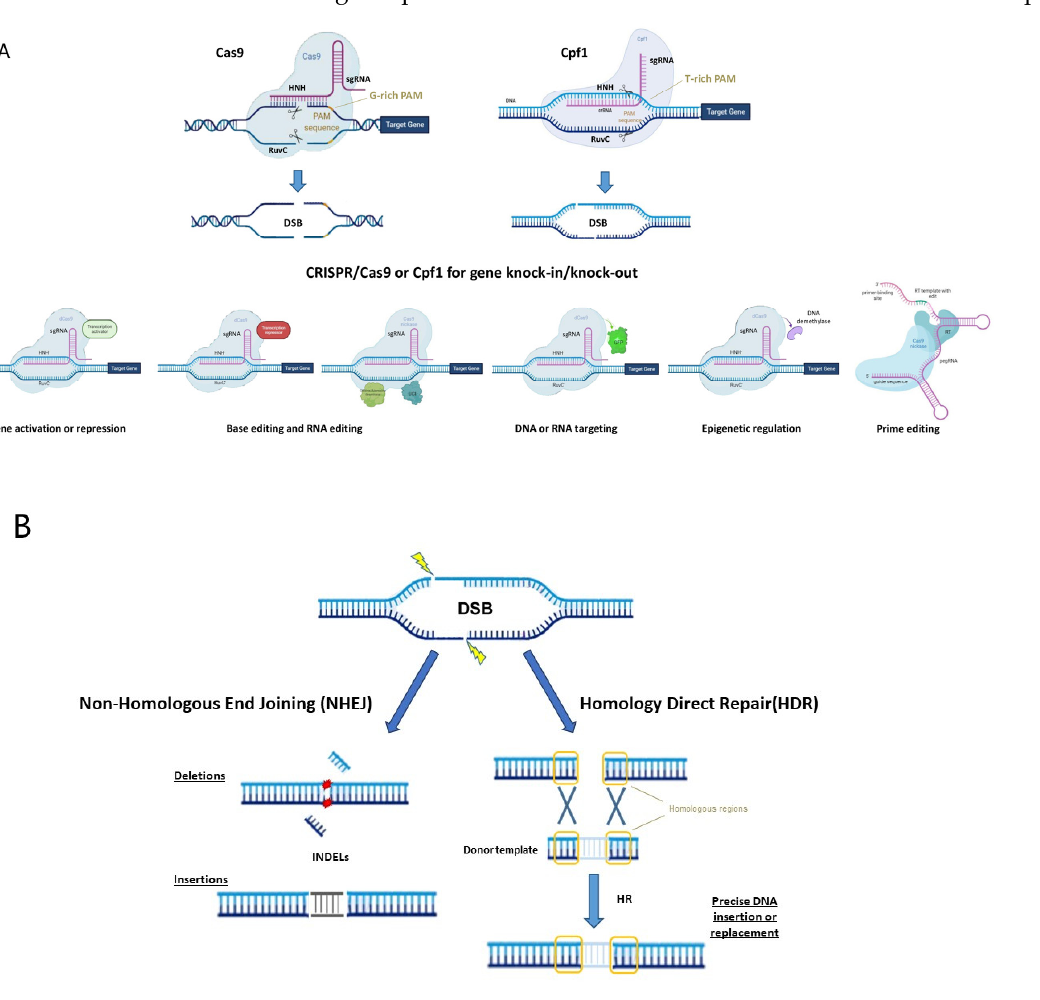
Figure 1. ( A ) Principal CRISPR/Cas9 or Cpf1 types of editing (top) and possible use for gene knock- in or knock-out (bottom), synthetic-guide RNA (sgRNA), double-strand break (DSB), protospacer- adjacent motif (PAM), reverse transcriptase (RT), uracil DNA glycosylase inhibitor (UGI), green fluorescent protein (GFP) and prime editing gRNA (pegRNA). ( B ) The two main DNA repair mecha- nisms and genetic